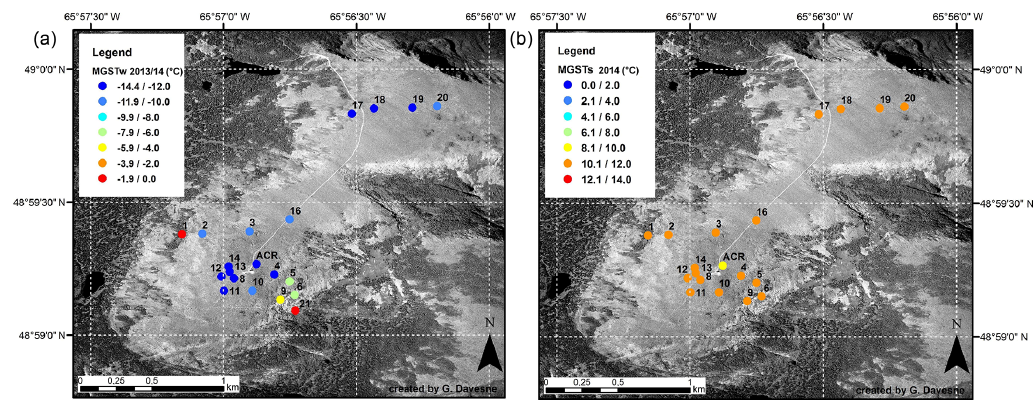
Figure 8. Maps of (a) the mean winter ground surface temperature (MGST w ) measured by the sensors over the Mont Jacques-Cartier during the winter (December–March) 2013–2014 and (b) the mean summer ground surface temperature (MGST s ) measured in summer (June–August)